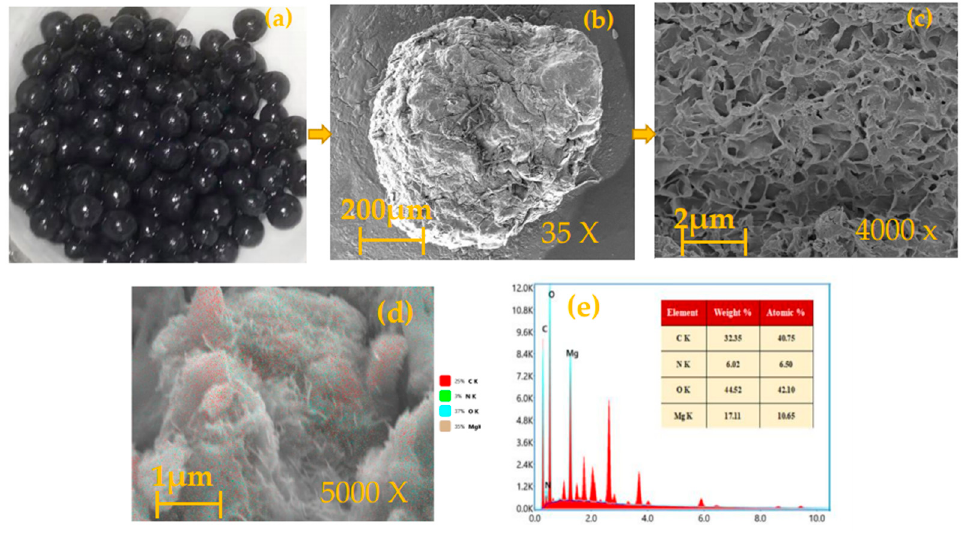
Figure 9. Optical and SEM images of ( a – c ) MBCQ, ( e ) spectrum and ( d ) EDS mapping of MBCQ.